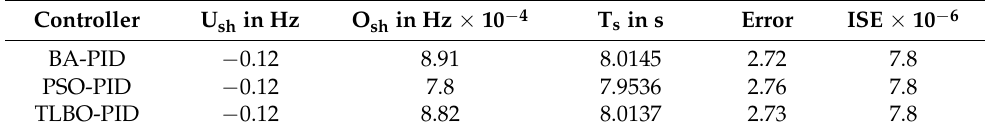
Table 9. Frequency response performances with FOPID tuned by different algorithms and designed by minimizing ISE.